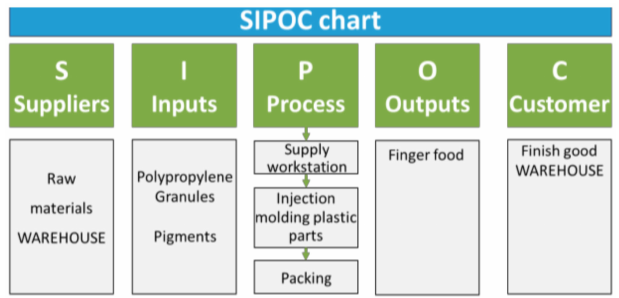
Figure 15. SIPOC chart of the production system “plastic injection”.